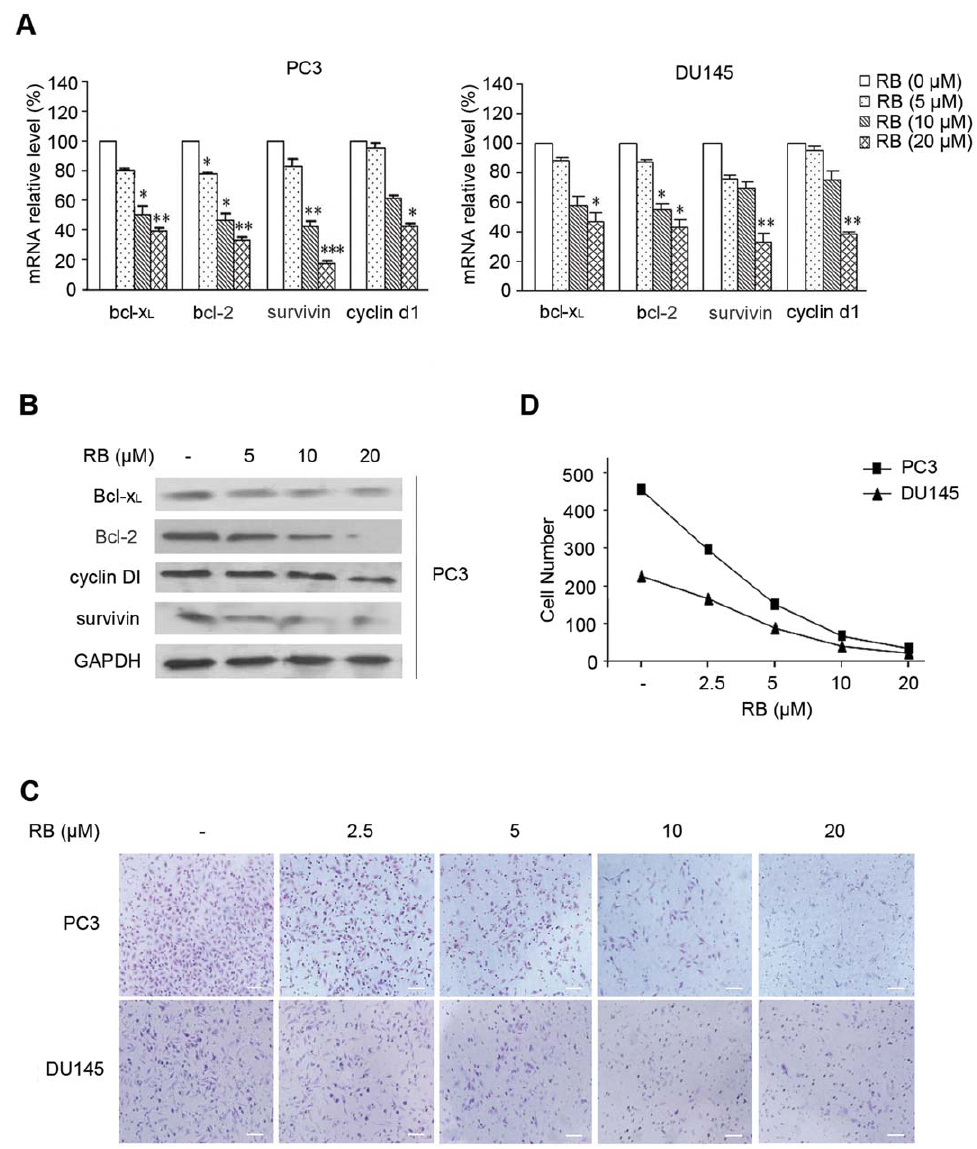
Figure 4. The effects of RB on function of NF- k B-dependent gene expresion and cell invasion invitro . (A) RB dosage-dependently inhibited the mRNA expression of Bcl-x L , Bcl-2, survivin, and cyclin D1 as analyzed by QRT-PCR. GAPDH was used for normalization. Results are the mean 6 SD of three independent experiments, each performed in triplicate. p , 0.05 (*), p , 0.01 (**), p , 0.001 (***) versus RB-untreated control group respectively. (B) RB dosage-dependently inhibited expression of Bcl-x L , Bcl-2, survivin, and cyclin D. The results of western blot analysis of whole cell lysates from PC3 cells treated with different doses of RB were shown; GAPDH was included as a loading control. (C) RB inhibited invasion of PCa cells in a concentration-dependently manner as detected by transwell assay, (scale bar, 100 m m). The procedure was described in Materials and Methods . (D) The number of cells that invade through matrigel.